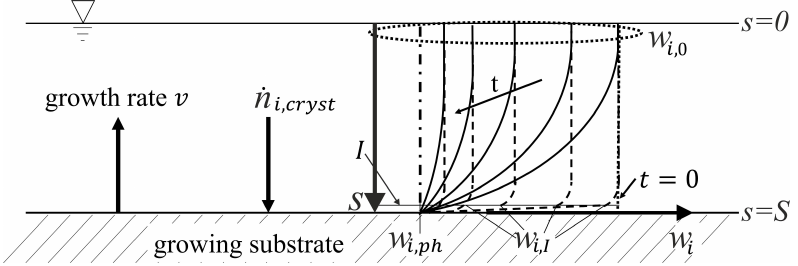
Figure 1. Schematic depiction of the mass fraction of component i crystallizing onto a substrate. The growth velocity v of a crystal is directed in the direction opposite the mass transfer ˙ n i , cryst . A concentration gradient occurs that diminishes with progression in time. The concentration profiles depicted in full lines correspond to the diffusion limitation of growth, while the dashed lines represent the integration limitation of growth. The initial state is shown with a dotted line, whereas the final state is depicted with a dashed dotted line. The indicated weight fractions are the solid interface fraction w i , ph , which is assumed to be at equilibrium, and the virtual integration boundary weight fraction w i , I